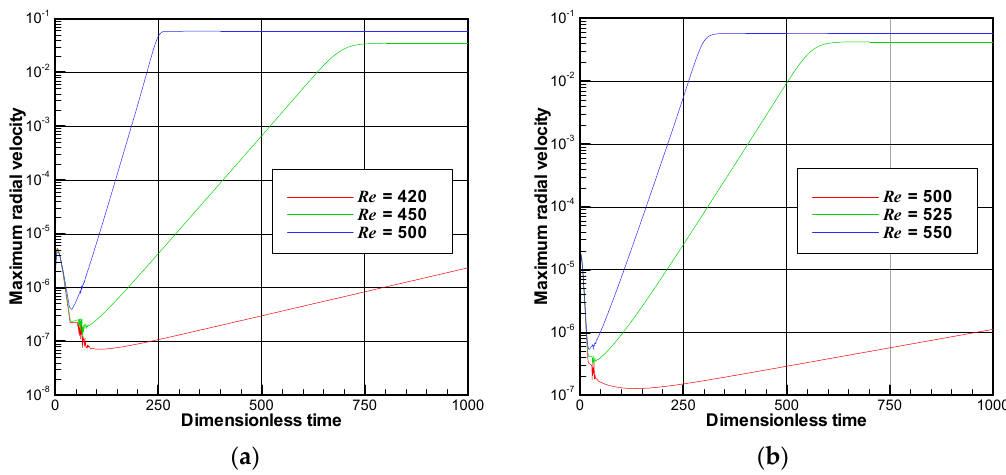
Figure 9. Growth rate of the maximum radial velocity for several values of the Reynolds number at A = 1 and m = 1. ( a ) Ha = 9; ( b ) Ha = 16.